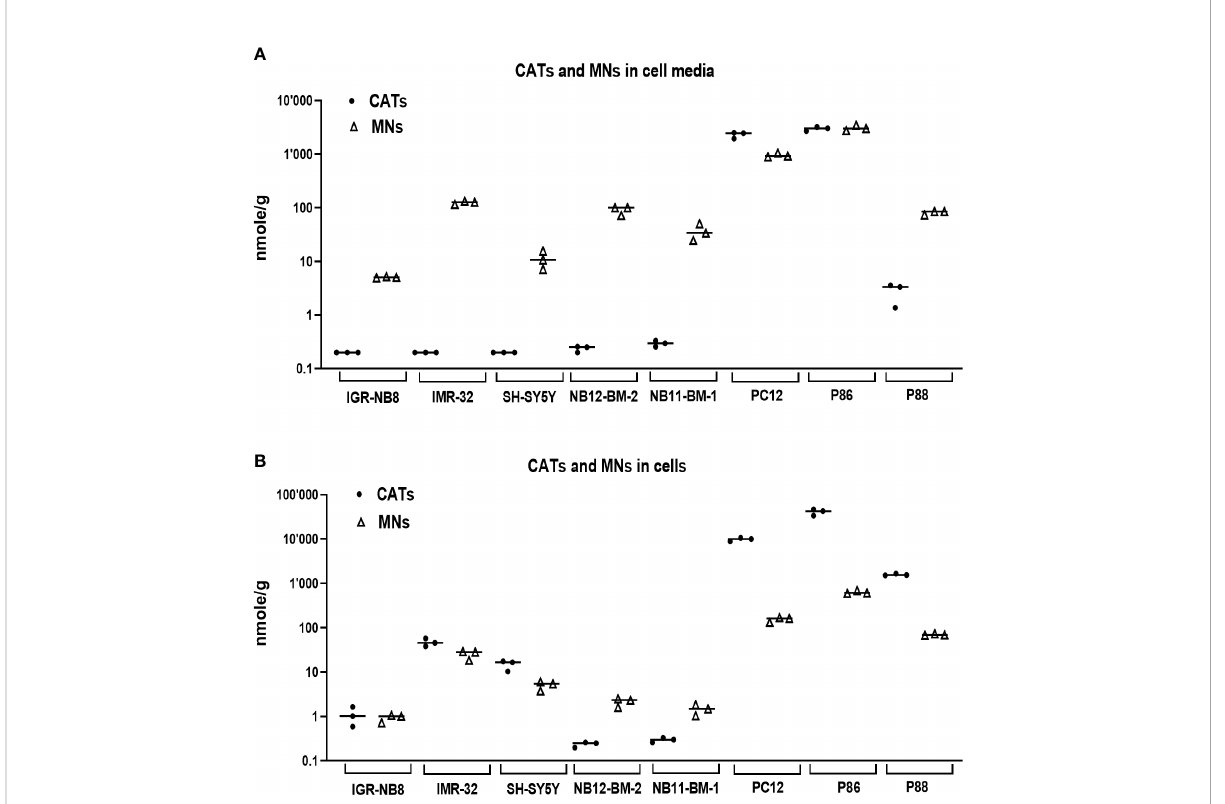
FIGURE 4 CATs and MNs concentrations in NB and PHEO/PGL cells in vitro and their culture media. (A) Quanti fi cation of sum of CATs (dots) and MNs (triangles) in cell culture medium (in nmol/g of protein in cell lysates) of three NB cells lines, two primary cell sample from NB-PDX (NB11-BM-1, NB12-BM-2), the PC12 cell lines, and two PHEO/PGL biopsies (P86 and P88). Assays were performed in triplicate and corresponding values are plotted in the graph with indication of the mean: IGR-NB8: 0.2 and 5.1 nmol/g for CATs and MNs respectively; IMR32: 0.2 and 125.2; SH-SY5Y: 0.2 and 11.1; NB12-BM-2: 0.24 and 91; NB11-BM-1: 0.3 and 36.4; PC12: 2300 and 957; P86: 2990 and 3087; P88: 2.8 and 81.3. Values under our limit of quanti fi cation were set at 0.025, 0.125 and 0.075 nmol/g for respectively E, NE and DA, which represent half of their lower limit of quanti fi cation (LLOQ). (B) Quanti fi cation of intracellular CATs and MNs (in nmol/g of protein) in the corresponding cell lysates from (A) Mean values: IGR-NB8: 1.1 and 0.9 nmol/g for CATs and MNs respectively; IMR32: 47.1 and 25.3; SH-SY5Y: 14.9 and 5.1; NB12-BM-2: 0.24 and 2.2; NB11-BM-1: 0.3 and 1.5; PC12: 9872 and 154.6; P86: 40910 and 634; P88: 1576 and